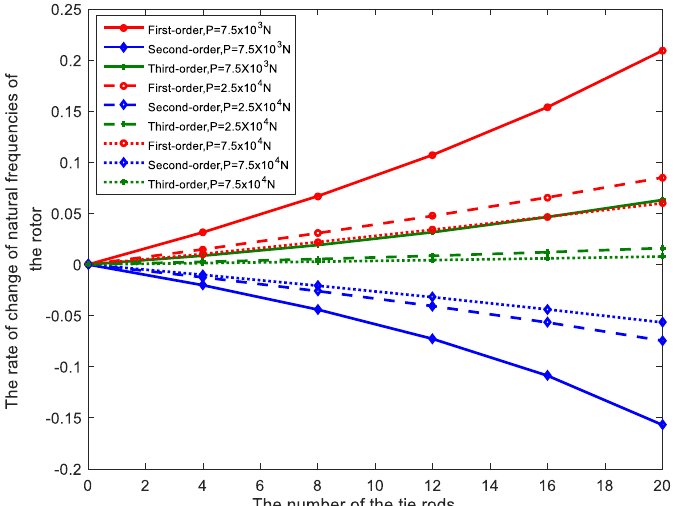
Figure 17. The rate of change of natural frequencies of the RFR with a different number of tie rods.